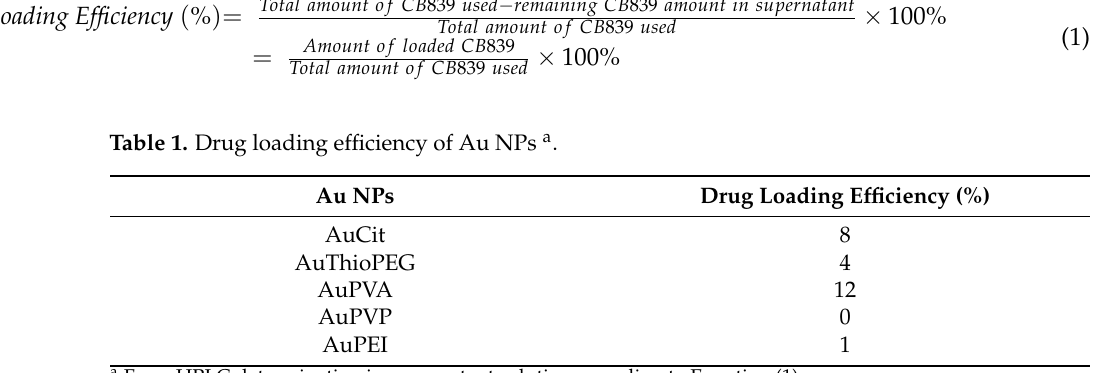
a From HPLC determination in supernatant solution according to Equation